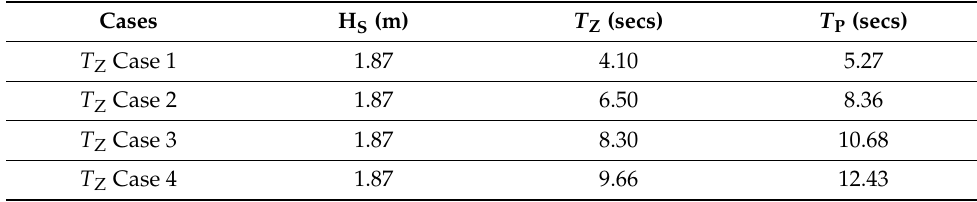
Table 14. Cases for Sensitivity of zero-crossing period, Tz.